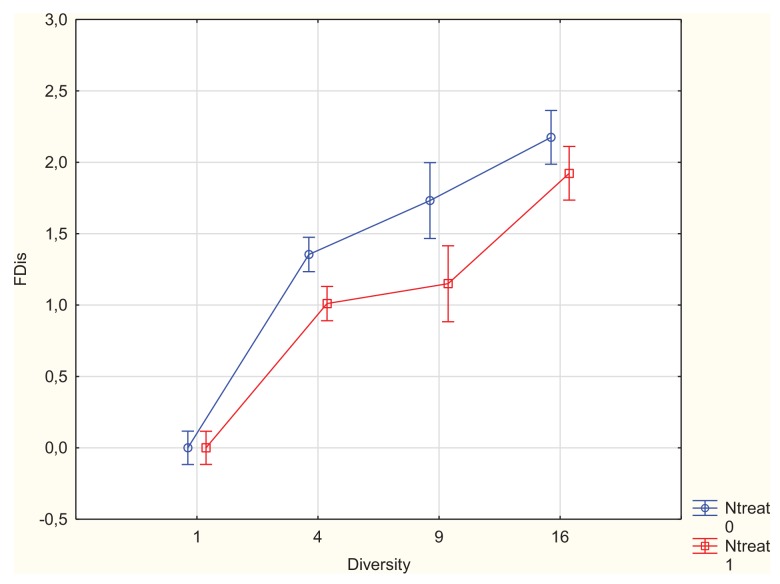
Plant species richness and N addition effects on Functional Dispersion in the BioCON experiment.For statistical results see main text. Means with 95% confidence intervals.